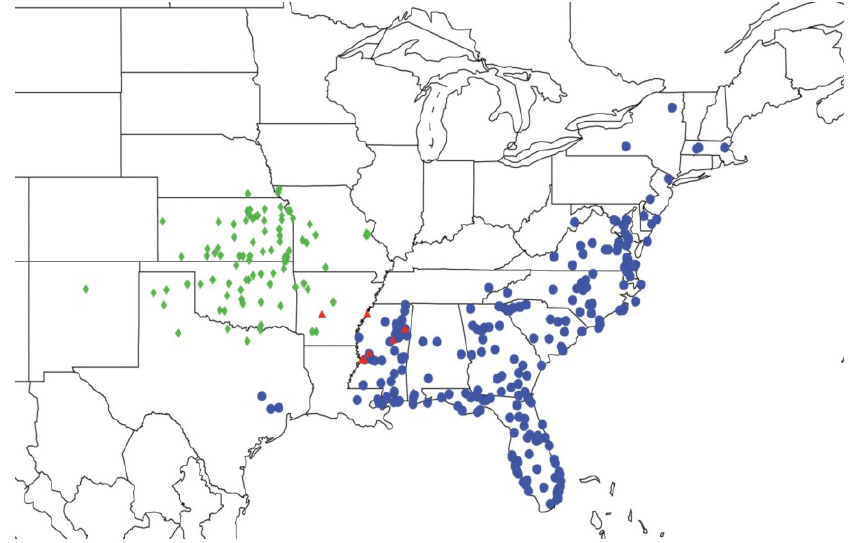
Figure 12. Distribution of Tibicen davisi davisi (blue circles), T. davisi hardeni (red triangles) and T. auriferus (green diamonds).